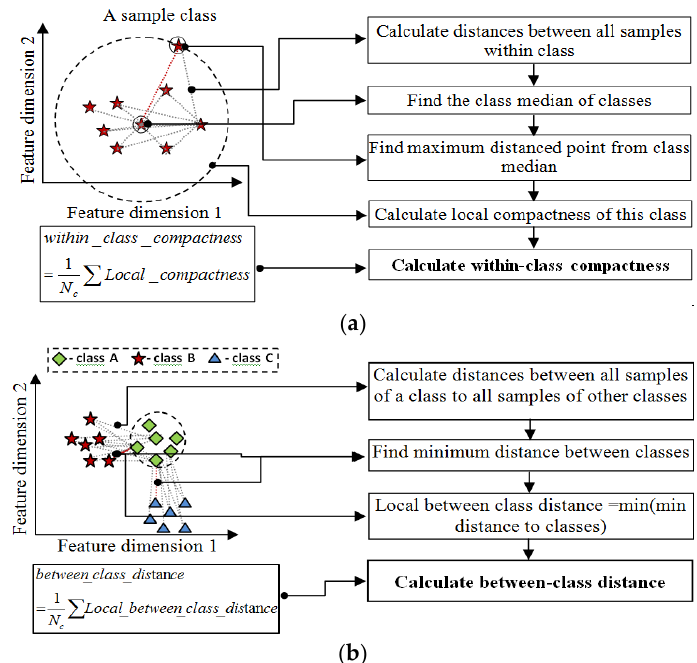
Figure 8. Feature subset evaluation algorithm: ( a ) Within-class compactness value, and ( b ) between- Figure8. Featuresubsetevaluationalgorithm: ( a )Within-classcompactnessvalue, and( b )between-class class distance value. distance